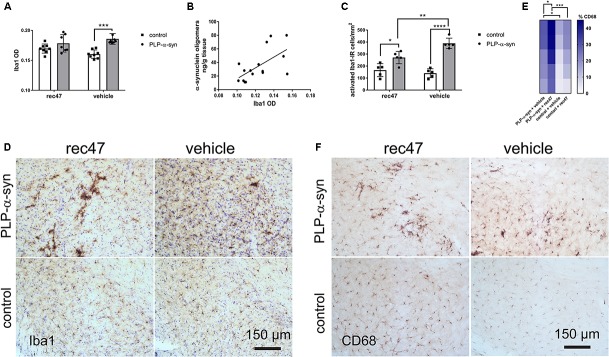
(A) Microglial activation measured by Iba1-immunoreactivity optical density in PLP-α-synuclein and control mice (∗p < 0.05, ∗∗∗p < 0.001). (B) Correlation between the level of α-synuclein oligomers and microglial activation in the hippocampus of PLP-α-synuclein mice (R2 = 0.381, p < 0.01), the analysis includes both immunized and non-immunized mice. (C) Microglial activation measured by the number of Iba1-immunoreactive cells with activated morphology per mm2 in PLP-α-synuclein mice and controls. (D) Representative microphotographs of Iba1 immunohistochemistry in SNc of control and PLP-α-synuclein mice receiving rec47 or vehicle (counterstaining with cresyl violet). (E) Heat map representation of the percentage CD68-positive microglia out of the total Iba1-positive microglia in the four experimental groups (∗p < 0.05, ∗∗∗p < 0.001). (F) Representative microphotographs of CD68 immunohistochemistry in SNc of control and PLP-α-synuclein mice receiving rec47 or vehicle.